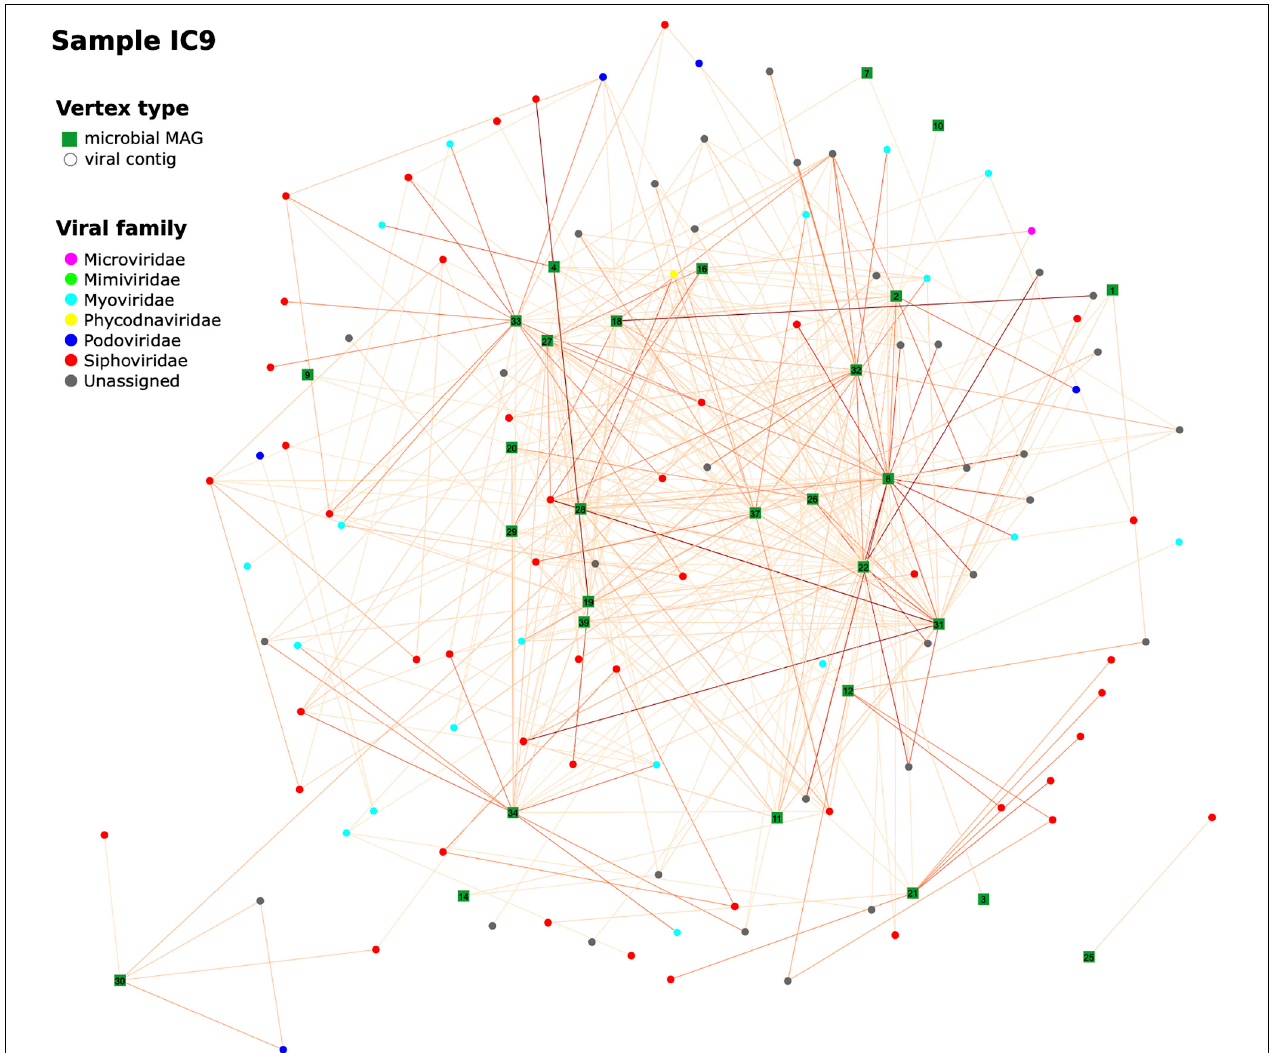
FIGURE 8 | Hi-C-based “virus-bacterial host” networks. The network for the sample IC9 is shown (see Additional File 1: Supplementary Figure 6 for the other samples). Edge-weighted Spring-Embedded algorithm was applied to generate the layout. Vertex shape corresponds to type (MAG or viral contig). The contigs forming each large microbial MAG were combined and shown as a square labeled with MAG ID. Each contig classified as viral was shown as a circle (particularly, if a viral contig had been assigned to a MAG, here it was extracted and drawn as a circle). Vertex color corresponds to viral taxonomy annotation obtained via DemoVir. The intensity of edge colors corresponds to the maximum of weight (normalized Hi-C linkage signal) between the contig and all contigs of the MAG. The MAG IDs are as listed in Additional File 3: Supplementary Table 3